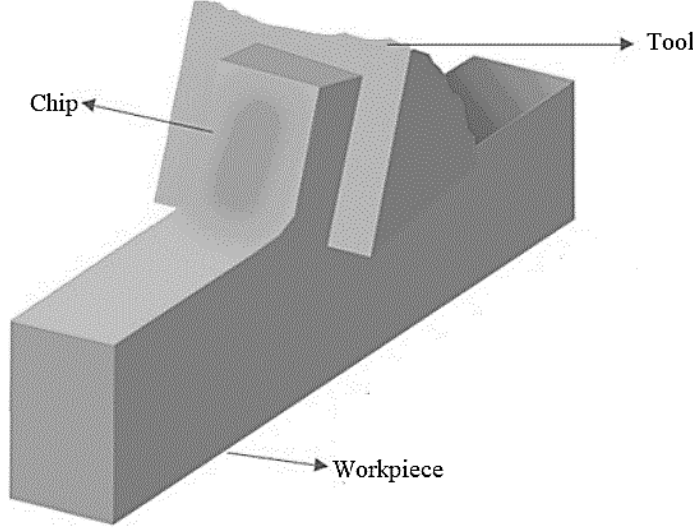
Figure 13. Modeling of turning operation.